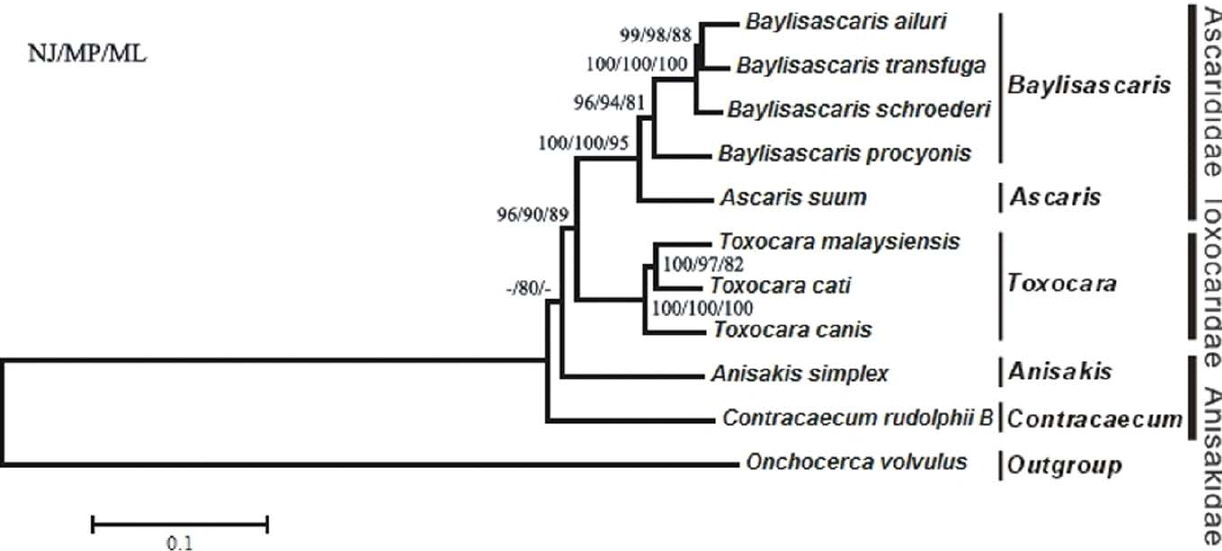
Figure 5. Phylogenetic relationships of ten Ascaridida species for which complete mtDNAs are available, inferred from NJ, MP and ML analysis for amino acid sequence data derived from 12 protein-coding genes, utilizing one filarioid species ( O.volvulus ) as the outgroup. Numbers above the branches represent bootstrap values derived from different analyses in the order: NJ/MP/ML. The scale indicates an estimate of substitutions per site, using the optimized model setting. The branches that were not universally supported with values of # 50% are indicated with ‘‘-’’ in each supporting values of the node.